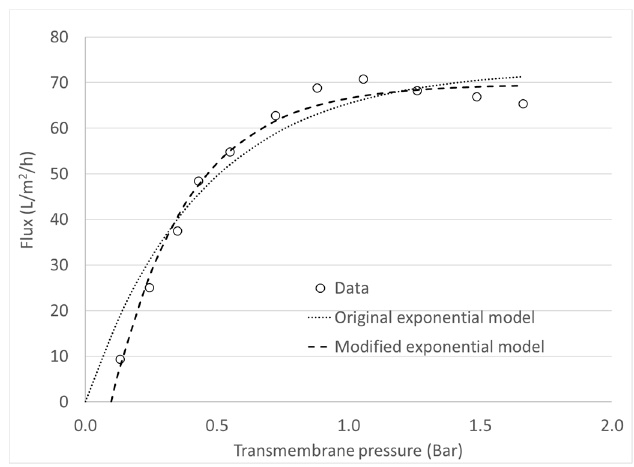
Figure 4. Comparison of data fitting to the original exponential model and the modified exponential model. Experimental conditions: Concentration factor of 1.0 with flow of 7.38 L/min at 40 °C using the membrane with a d h of 3.6 mm.